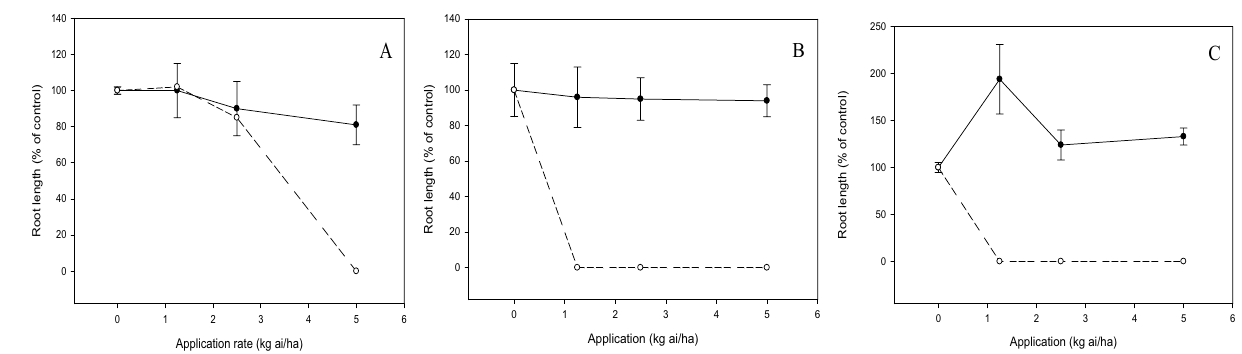
Figure 10. Phytotoxic effects of c (soild line) and diuron (dashed line) treatment on root length of Brassica rapa ( A ), Oryza sativa ( B ) and Zea mays ( C ) 2 weeks after pre-emergence application.